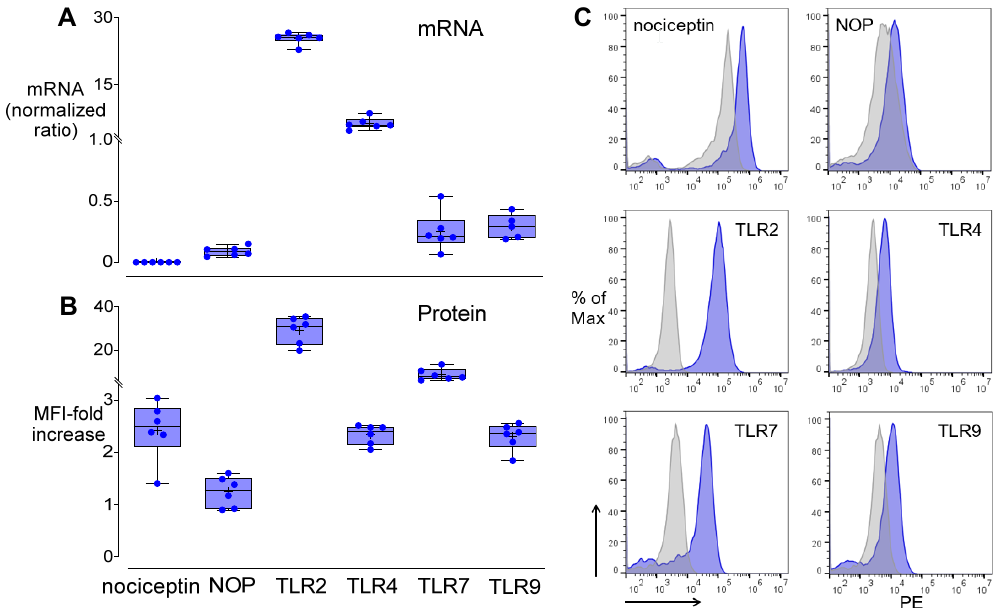
Figure 5. Constitutive nociceptin, NOP, TLR expression patterns in THP ‐ 1 cells. ( A ) Basal levels of ppNOC , NOP , TLR2 , TLR4 , TLR7 , and TLR9 mRNA expression. ( B ) Basal levels of nociceptin, NOP, and TLR proteins. (C) Representative histogram plots of cell membrane NOP, TLR2, TLR4, and intracellular nociceptin, and TLR7 and TLR9 protein levels. Cells were stained with specific antibodies for nociceptin, NOP, TLR2, TLR4, TLR7, or TLR9 (blue ‐ filled histogram). The grey ‐ filled histogram represents samples stained with respective isotype control antibodies. Flow cytometry data are presented as mean fluorescence intensity (MFI) related to the respective isotype controls. Boxplots with individual data points, median, IQR, and mean “+”; n = 6.